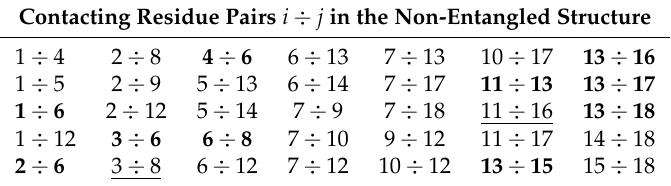
Table 2. For the twin protein structure (Figure 1b) without link, pairs i ÷ j for which ∆ i , j = 1. Underlined pairs refer to the contacts at the ends of loops discussed in this work. Pairs in bold-face (10 over 35) refer to the contacts that are not present in the entangled structure (Table